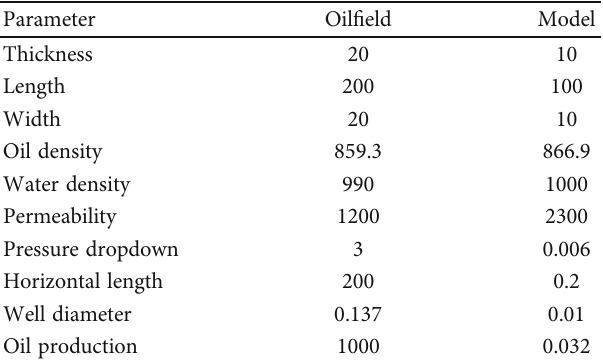
Table 2: Parameter comparison of physical model with that of oil fi